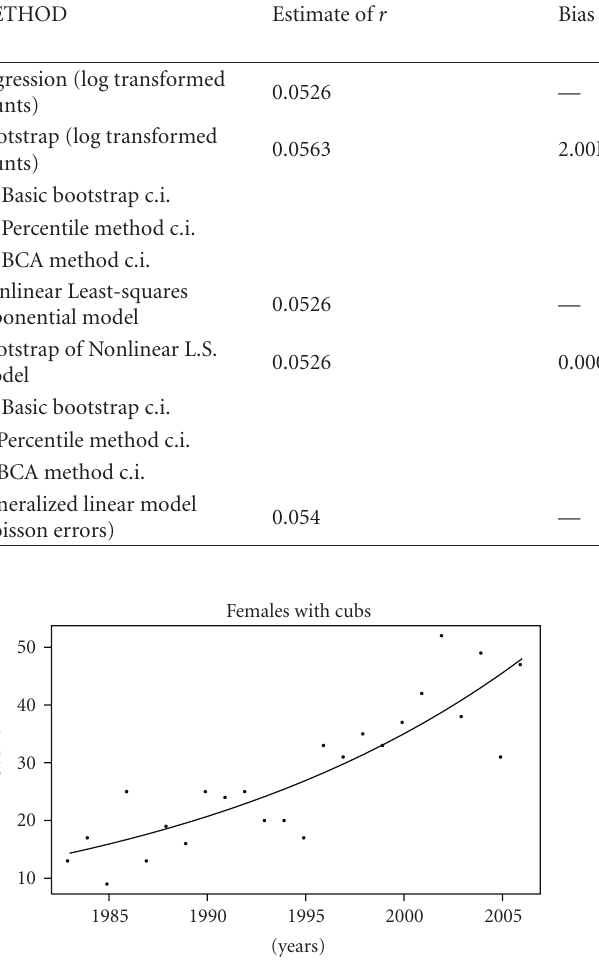
Figure 2: Plot of “unduplicated” data with fitted exponential function.